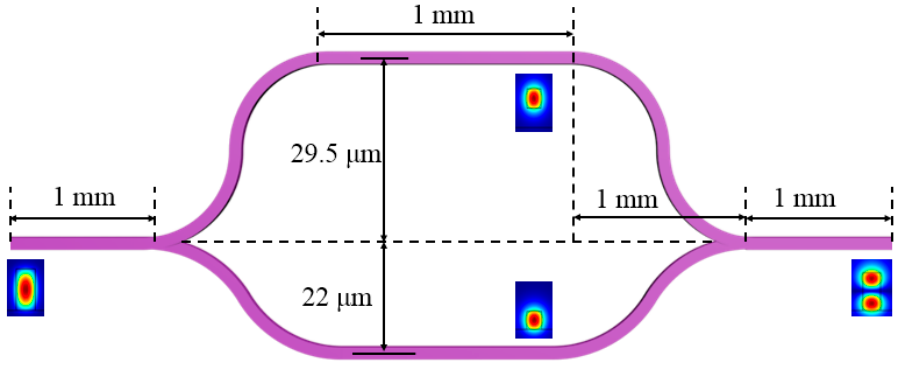
Figure 3. Schematic diagram of the mode converter.